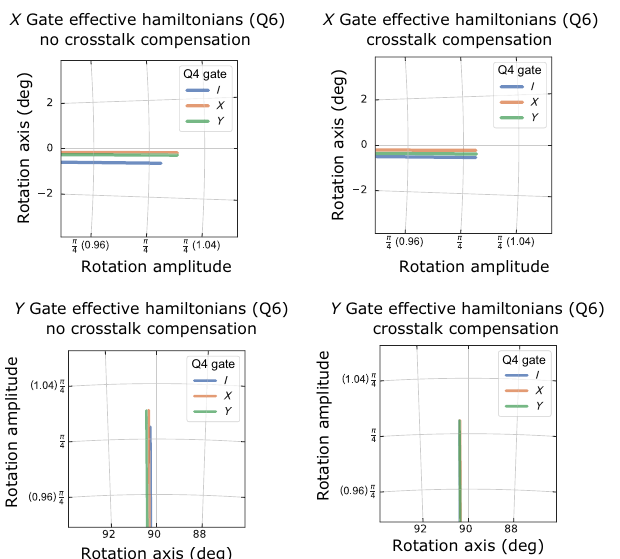
FIG. 3. Coherent errors in X π/ 2 and Y π/ 2 gates on AQT Q6 depend on context. We use GST to estimate one-qubit process matrices describing the X π/ 2 (top) and Y π/ 2 (bottom) gates on Q6 conditional on { I , X π/ 2 , and Y π/ 2 } gates performed at the same time on Q4, both without (left) and with (right) crosstalk compensation. We extract the effective Hamiltonian that gener- ates the unitary part of each estimated process (see the main (cid:11) text), represent it as H eff = h · (cid:11) σ [with (cid:11) σ = ( X , Y , Z ) ], and plot the projection of each one into the X - Y plane (all h Z compo- nents are negligible). Each of the four panels shows a small region of the X - Y plane; each effective Hamiltonian is repre- sented by a line from the origin to ( h X , h Y ) . Uncertainty regions are shown as ellipses, which are too small to be visible here. Both rotation angles and axes vary significantly from context to con- text; crosstalk compensation reduces this effect, and essentially eliminates it for the Y π/ 2